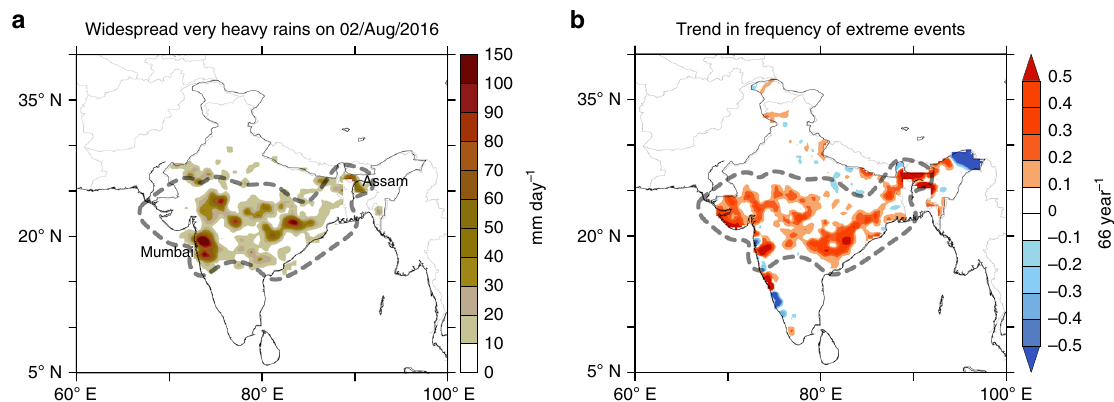
Fig. 7 Precipitation distribution during the recent fl oods over central India. a Precipitation (mm day − 1 ) on 2nd August 2016, which resulted in widespread fl oods across India. Precipitation values are based on the TRMM Multi-satellite Precipitation Analysis (TMPA, 3b42). b Observed trend in the number of extreme precipitation events during 1950 – 2015. Dashed line indicates the central Indian belt where the widespread extreme rain events are